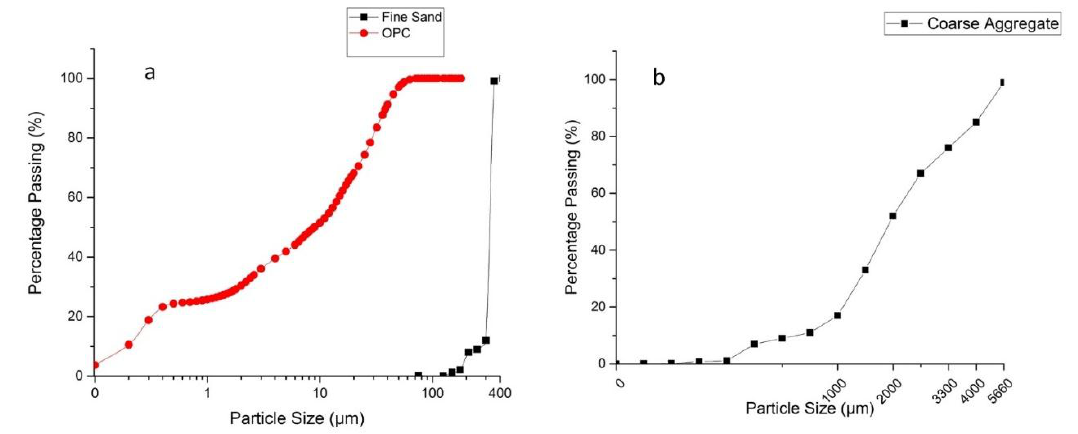
Fibre Type Fibre Type